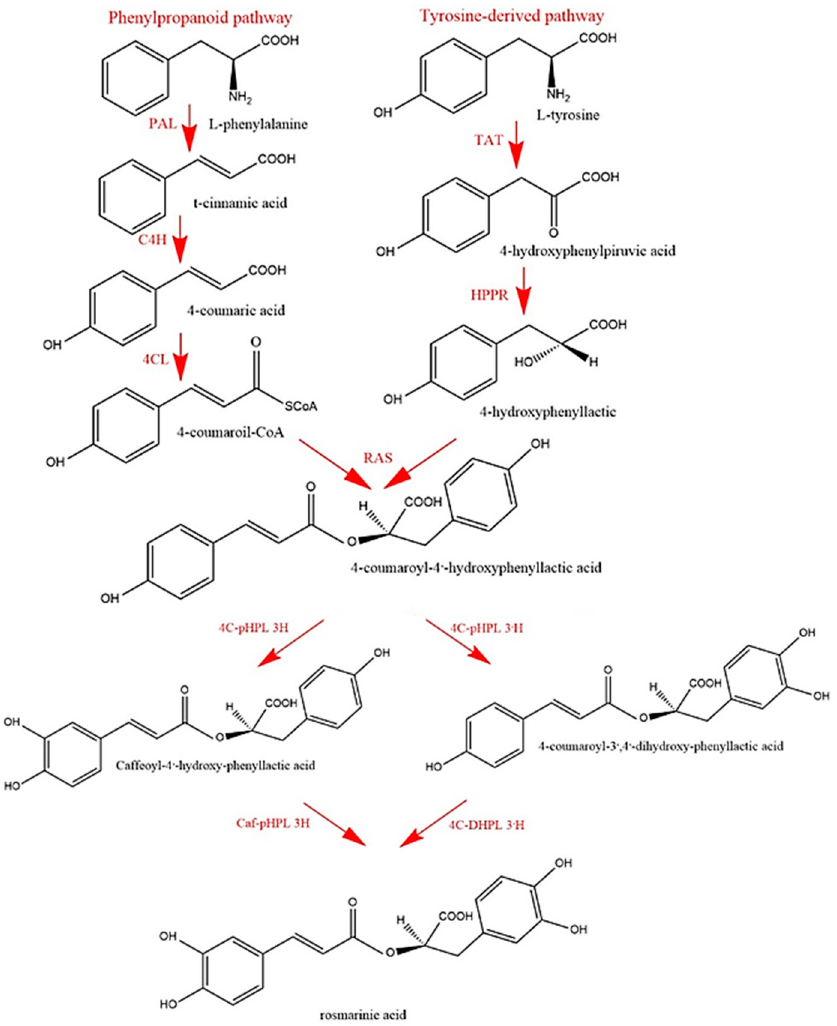
Figure 2. Scheme of the biosynthetic pathway of rosmarinic acid in Coleus blumei . PAL: phenylalanine